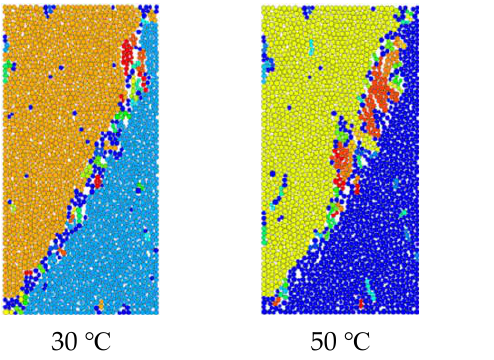
Figure 10. Deviatoric stress – strain and energy evolution curves. This was mutually verified with the AE event peak lagging behind the peak intensity. The micro-cracks extended into macroscopic cracks and failure surfaces, and the sample was divided into coal blocks (Figure 11). The elastic energy stored in the coal body was released in large quantities, which was converted into the friction energy between coal blocks and the friction energy in the damper, namely the dissipative energy specified in this paper.